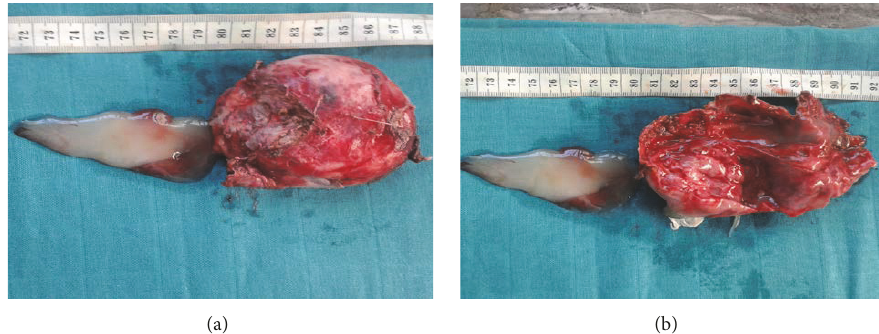
Figure 4: Gross examination: the opened mass showed a double component: a cystic and a fleshy one, with an outcome of a mucous material at the opening ((a)-(b)).